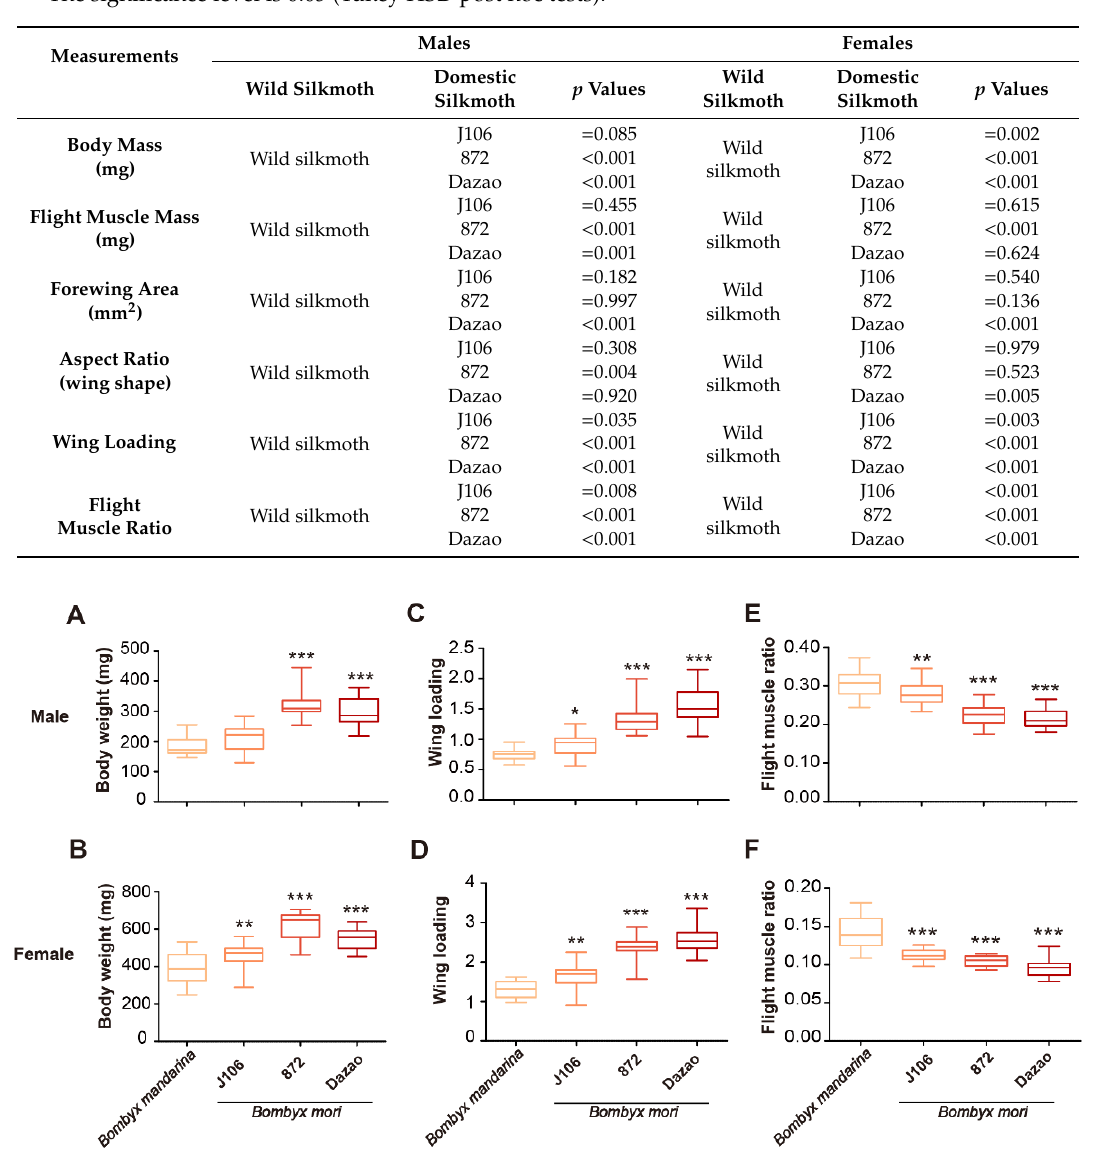
Figure 2. Body weight (mg), wing loading and flight muscle ratio of silkmoths. The five points of box-plot from top to bottom represent the maximum value, the 75th percentile, the 50th percentile (median), the 25th percentile and the minimum value. The box color from light orange to dark red represent B. mandarina , J106, 872 and Dazao, respectively. The X -axis of the above figures were the same as the bottom. We compared B. mandarina to J106, 872, Dazao, respectively using ANOVA. Tukey HSD post hoc tests are shown in Table 3. The significance level is 0.05 (* p < 0.05, ** p < 0.01, *** p < 0.001). The body weight (mg) of B. mori was larger than that of B. mandarina in males ( A ) and females ( B ). The wing loading of B. mori was significantly larger than that of B. mandarina in males ( C ) and females ( D ). The flight muscle ratio of B. mori was significantly lower than that of B. mandarina in ( E ) males and ( F )